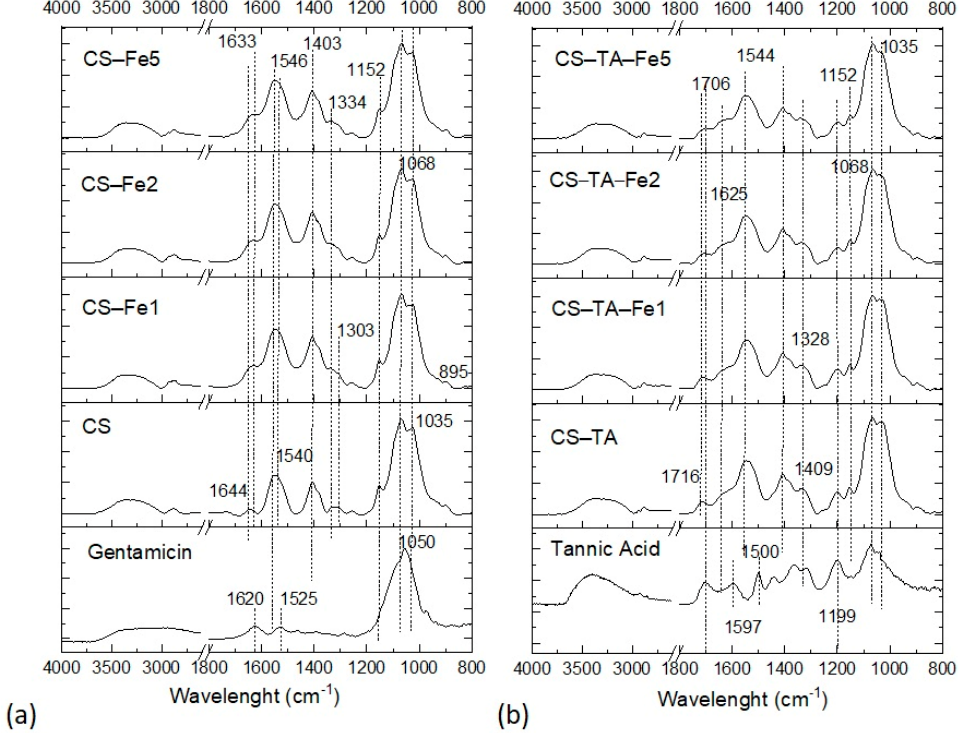
Figure 2. FTIR spectra of the films ( a ) without tannic acid (TA) and ( b ) with tannic acid with increas- ing amount of iron (Fe) (from bottom to top). Gentamicin sulfate and tannic acid are given as refer- ences.